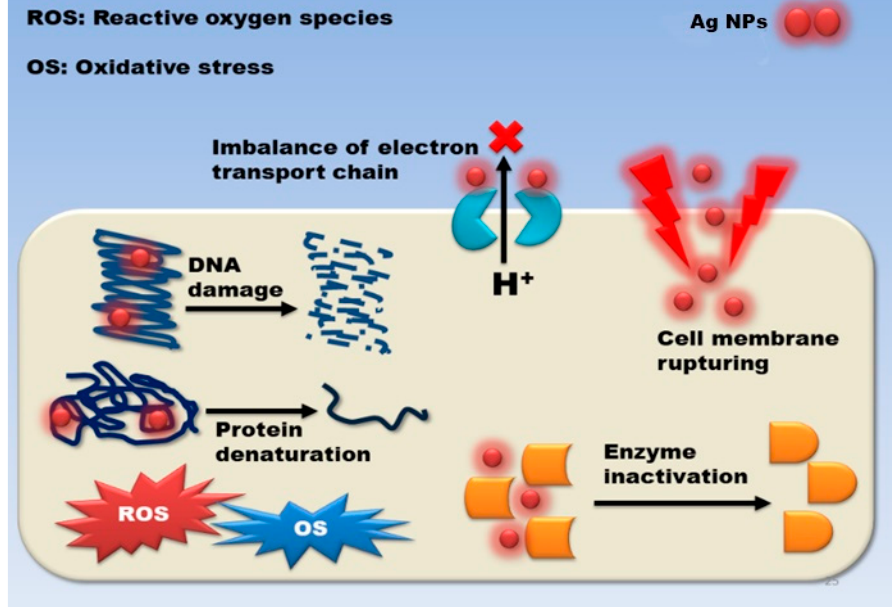
Figure 8. Silver nanoparticles’ antibacterial mechanism of action is described in general terms